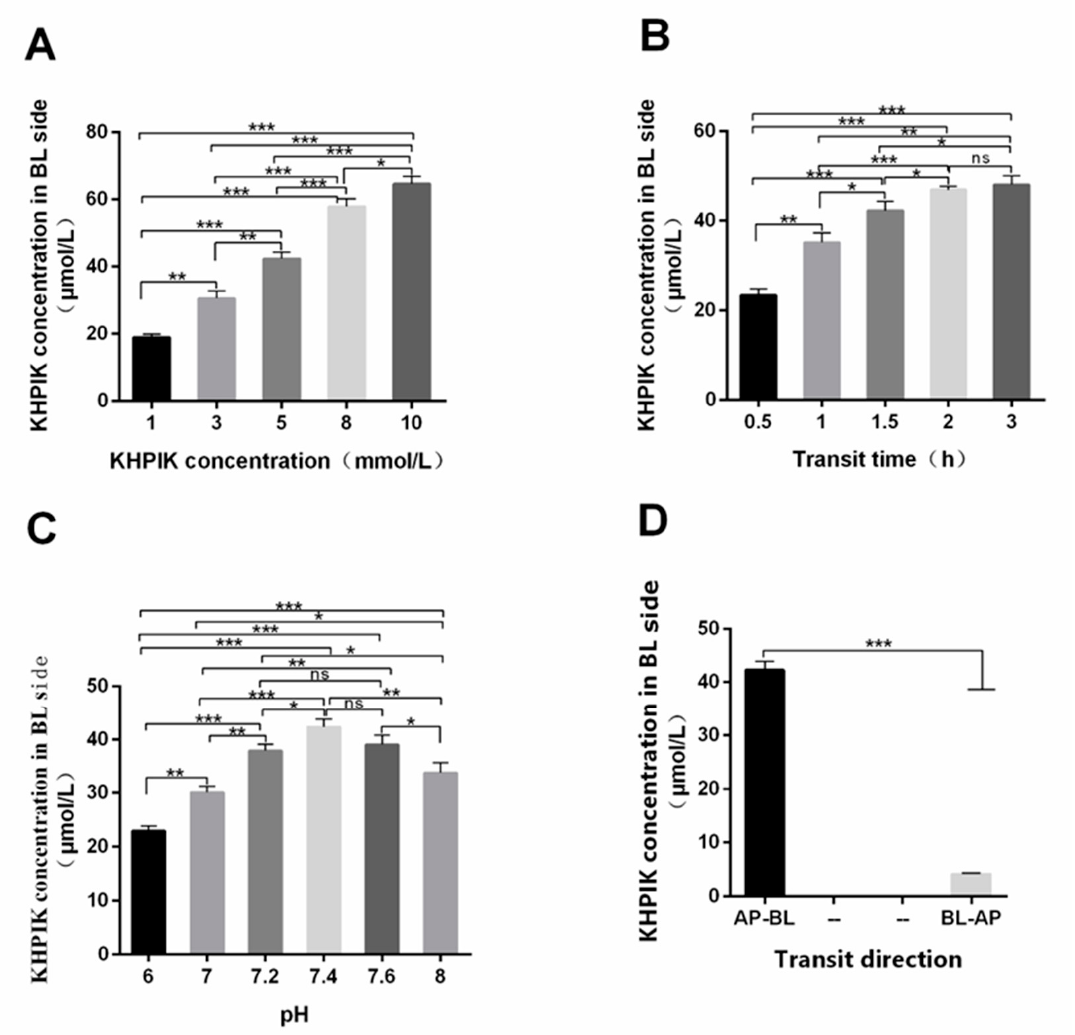
Figure 4. The optimal transportation of conditions of KHPIK. ( A ) effect of KHPIK concentration on transportation. ( B ) effect of incubation time on transportation. ( C ) effect of KHPIK pH on transportation. ( D ) effect of KHPIK transit direction on transportation. Data is presented as the mean ± SD ( n = 6). ns, p > 0.05; *, p < 0.05; **, p < 0.01; ***, p < 0.001 versus the control group.